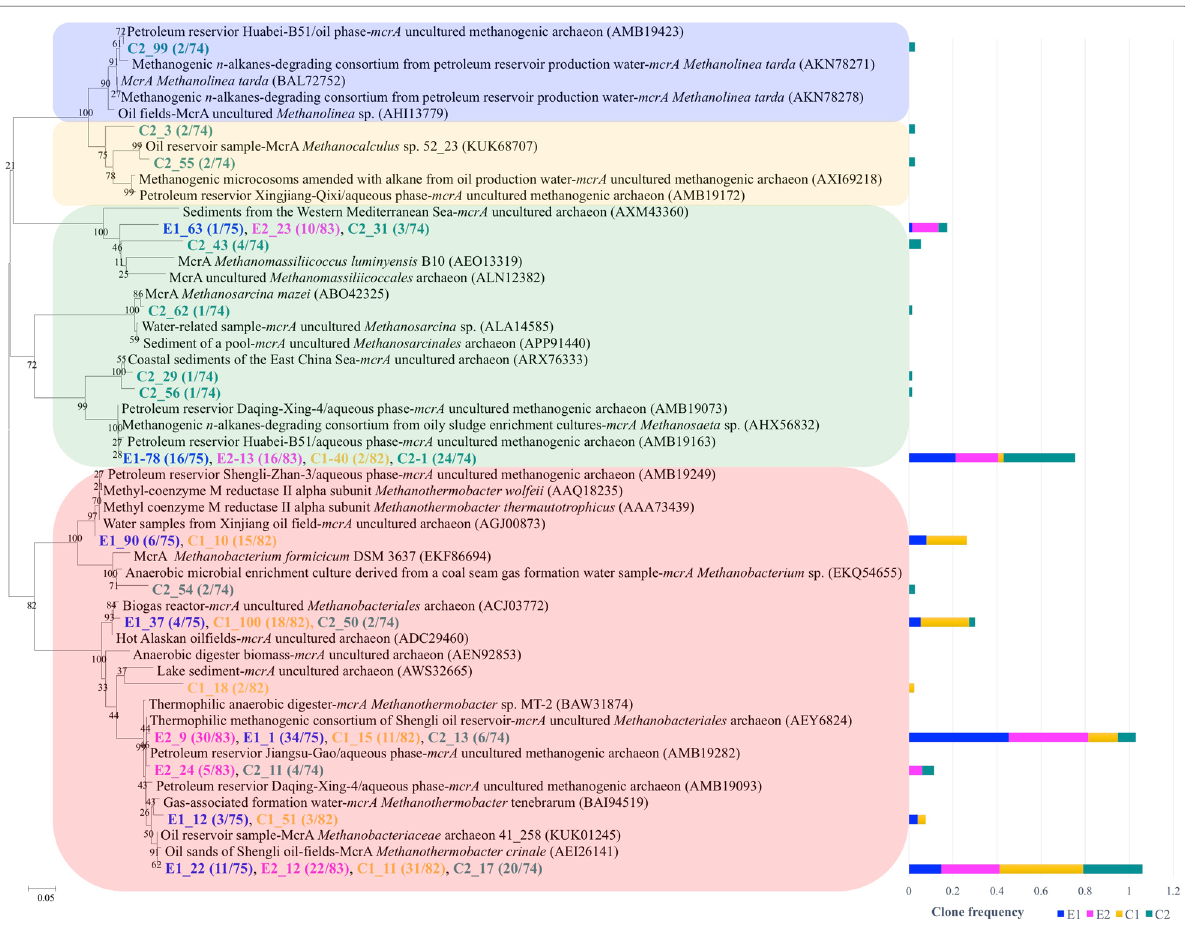
Fig. 3 The phylogenetic tree of mcrA gene in cultures enriched from production water amended with long‑chain n ‑alkanes during 736‑day